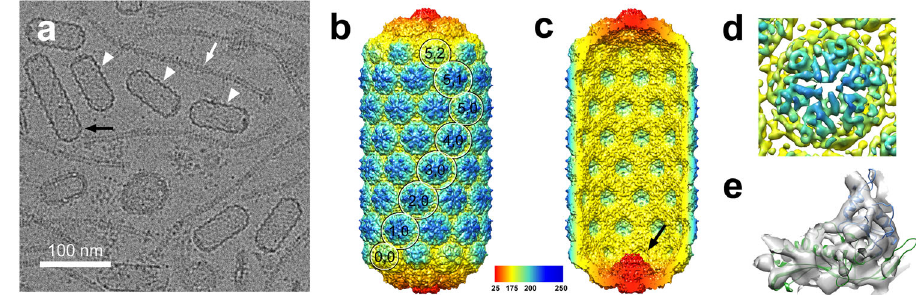
Fig. 1 Reconstruction of the ϕ 12 procapsid. a Representative cryo-electron micrograph of ϕ 12 procapsids (white arrowheads). The white arrow indicates a phage tail; the black arrow points to a capsid with abnormal length. Scale bar = 100 nm. b Isosurface representation of the C5 symmetrical ϕ 12 procapsid reconstruction, rendered at four standard deviations above the mean (4 σ ), and colored radially from the central fi vefold symmetry axis according to the color bar. The T mid = 14 lattice ( h , k ) is indicated. c Cutaway view showing the inside of the ϕ 12 procapsid. The portal is visible at the bottom vertex (black arrow). d Close-up view of the density corresponding to one of the central midsection hexamers (5 σ ). e Ribbon diagram of HK97 gp5 (PDB ID: 3E8K) with the A- and P-domains (blue and green, respectively) individually rigid-body fi tted into one subunit in the hexamer density.